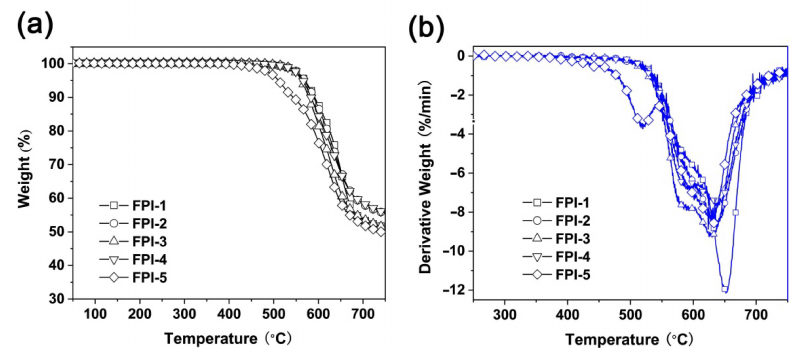
Figure 8. Thermal decomposition behaviors of FPI UFMs. ( a ) TGA and ( b ) DTG.